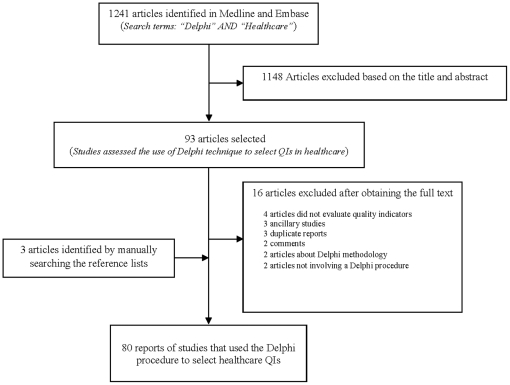
Study selection.